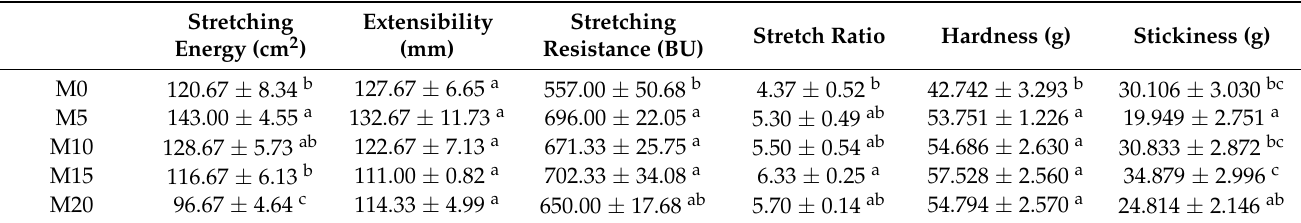
Table 4. Extensograph and texture properties of high-gluten wheat flour with 0% (M0), 5% (M5), 10%